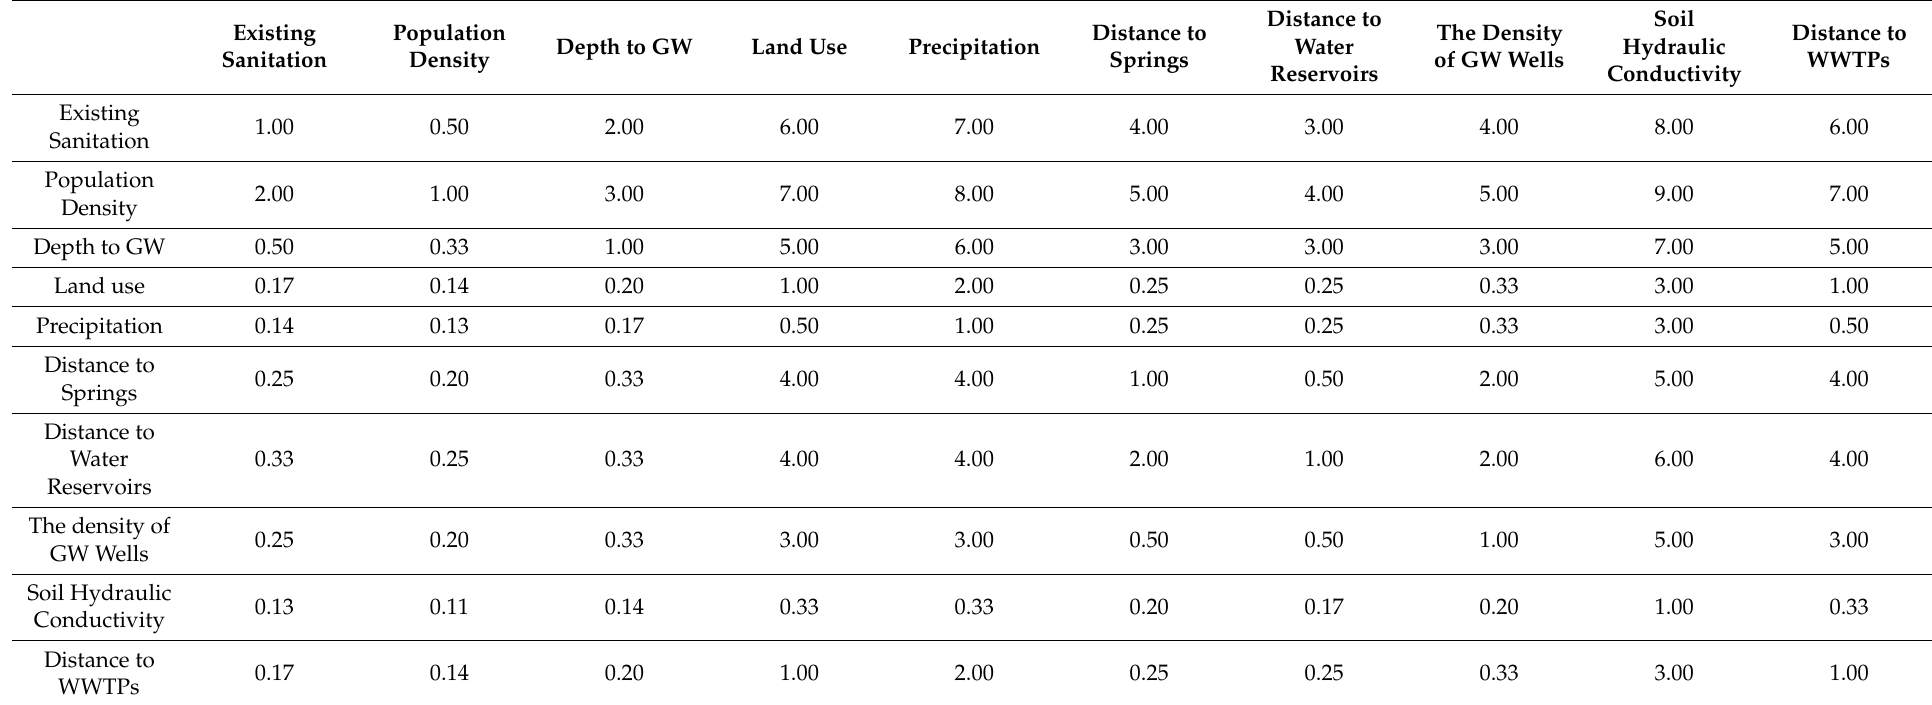
Table 2. AHP Pairwise matrix for the selected criteria.